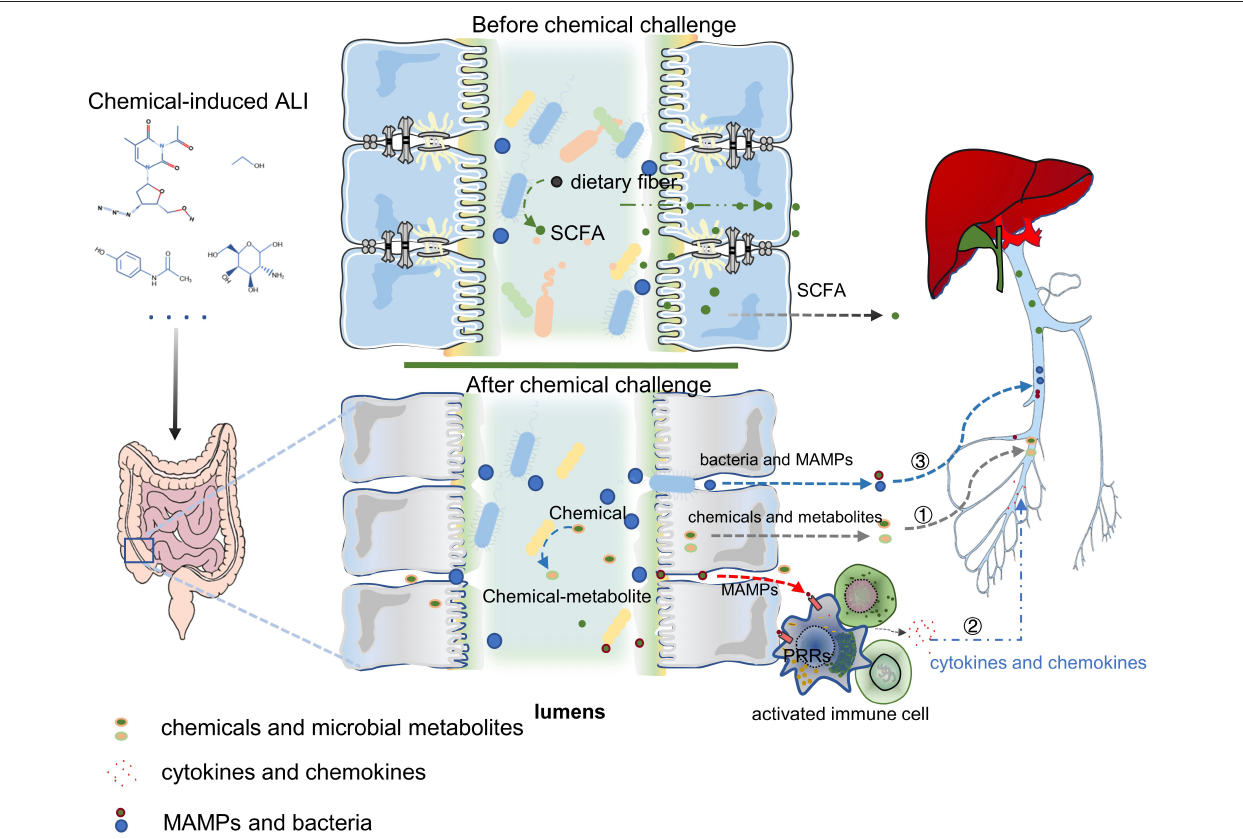
FIGURE 2 | The mechanism of gut microbiota in ALI can be summarized by three points: ‹ Chemicals transformation and metabolites of gut microbiota can influence the hepatocyte’s ability to metabolize toxic substances and affect hepatic function; › Gut harmful bacteria and MAMPs activate the systemic immune response, release a large number of chemokines and pro-inflammatory cytokines into the liver, leading to liver inflammation; fi Intestinal mucosal barrier destroy (containing the weakening of the mucus barrier, the destruction of cell tight junction, and the necrosis of intestinal epithelial cells) increases bacterial translocation and the entry of MAMPs into the liver, which mediates liver damage. PRRs, Pattern Recognition Receptors. Figure was partly adapted from Smart Servier Medical Art (https://smart. servier.com/), which is licensed under a Creative Common Attribution 3.0 Generic